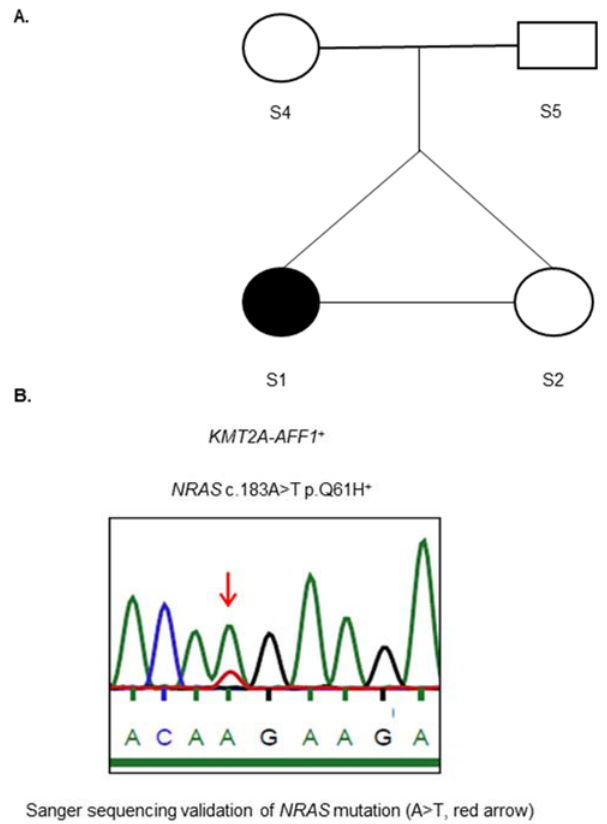
Figure 1. ( A ) Twins’ family tree. ( B ) Genetic alterations in the proband at diagnosis.